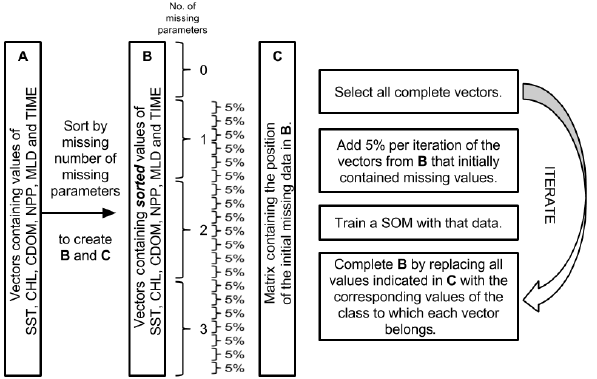
Figure 6. A schematic of the imputation method used. We initially sort the data depending on the amount of missing values present, then progressively train SOMs on the data set, steadily including more vectors for the training and completing and updating the miss- ing data during each iteration.